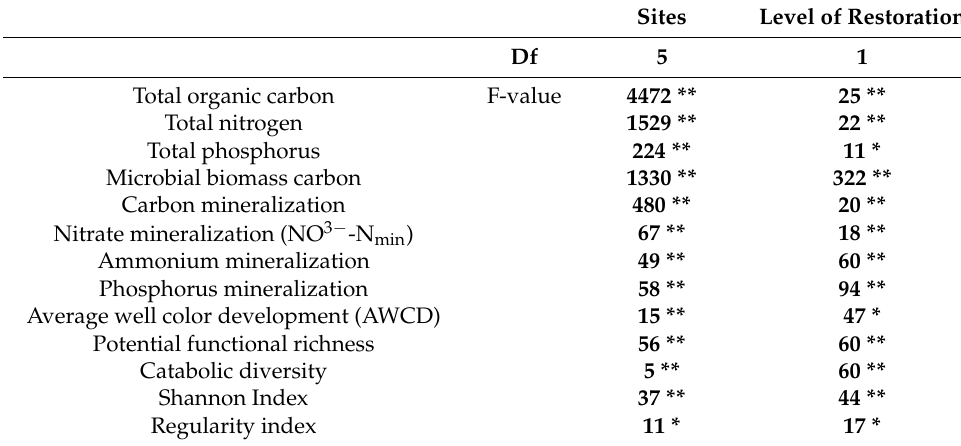
Table 4. Effects of vegetation and level of restoration in a one-way ANOVA. Bold values are significant ( p < 0.05), “*” indicates a p -value 0.01 < p < 0.05, “**” indicates a p -value 0.001 < p < 0.1. Sites Level of Restoration Df Total organic carbon F-value 4472 ** Total nitrogen 1529 **